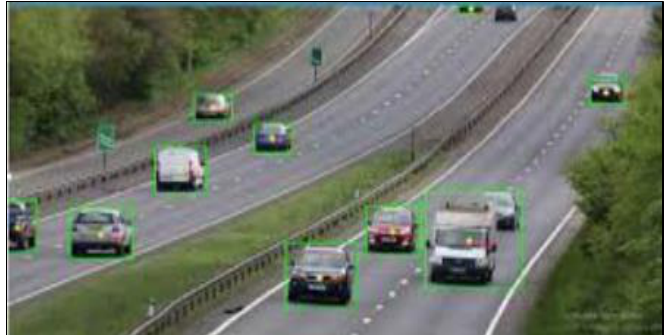
Figure 6: Detecting moving